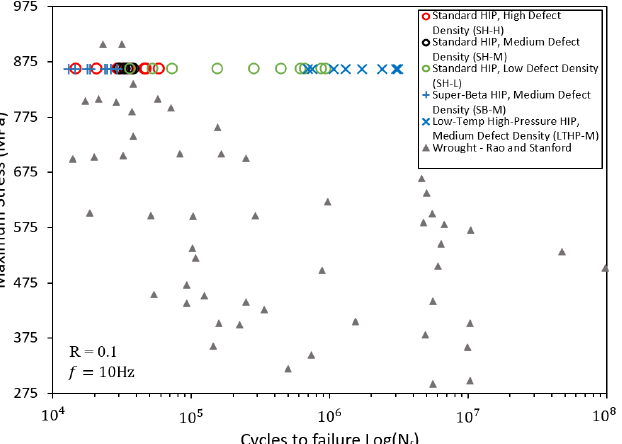
Figure 6. Fatigue life of all AM Ti-6Al-4V specimens tested in this work, with results for wrought Ti-6Al-4V aggregated by Rao and Stanford